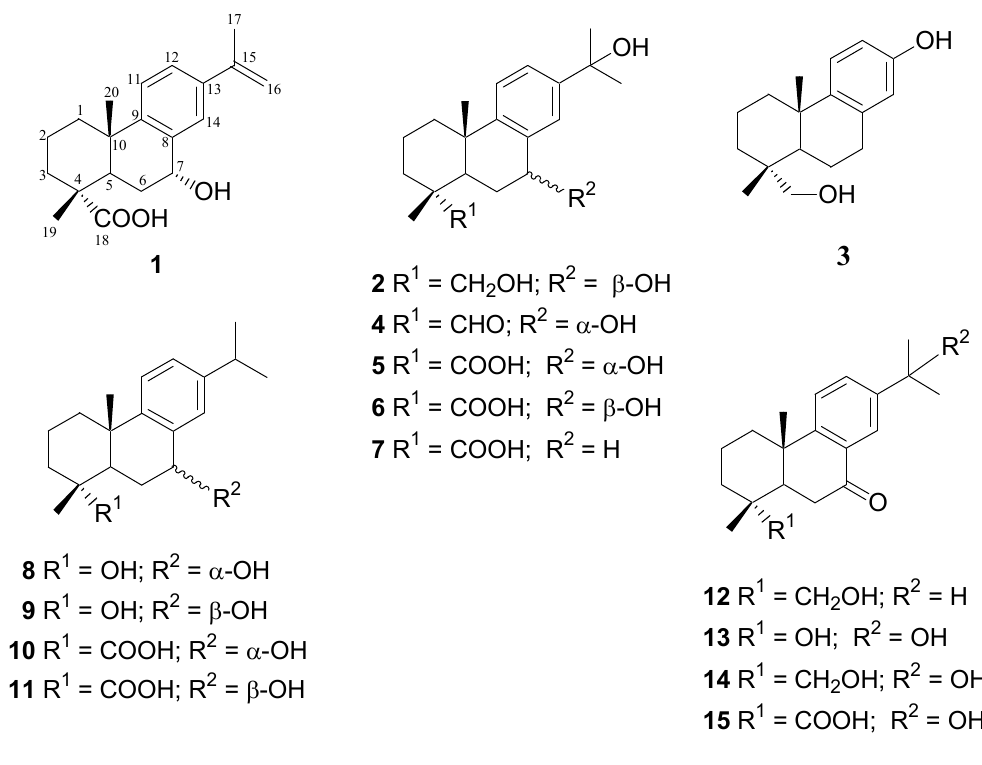
Figure 1. Diterpenes from buds of Pinus banksiana